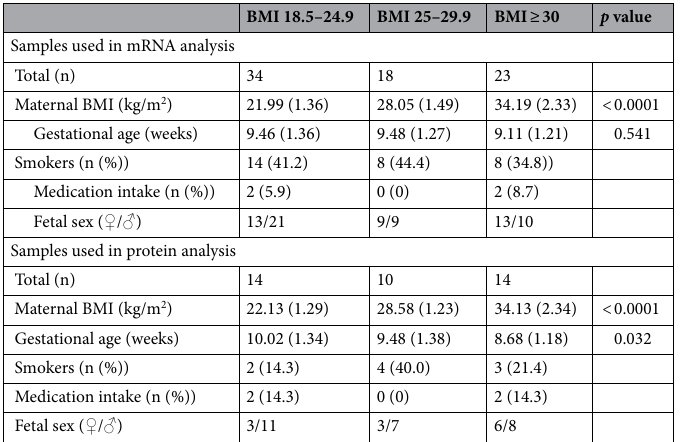
Table 2. Characteristics of first trimester placental samples used for mRNA and protein expression analysis. Maternal BMI and gestational age are given as mean ± standard deviation (SD). One-way ANOVA was used to identify significant difference between groups. BMI: body mass